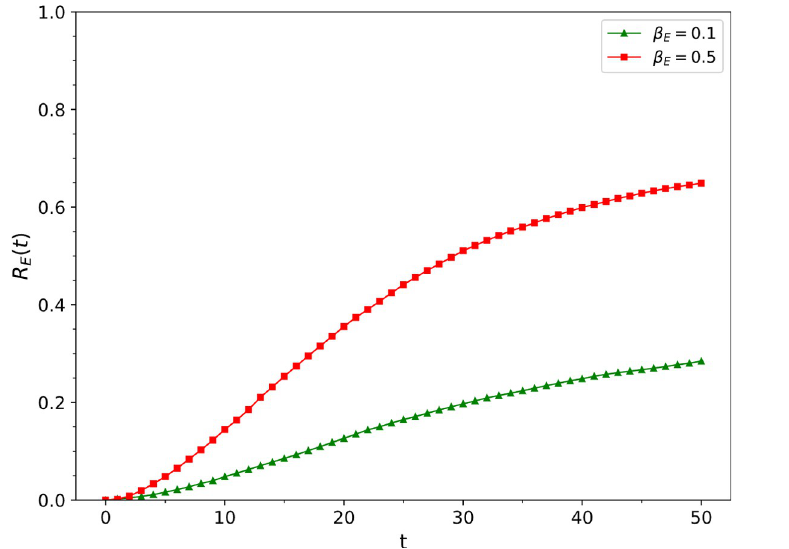
Fig 5. The influence of epidemic transmission rate β